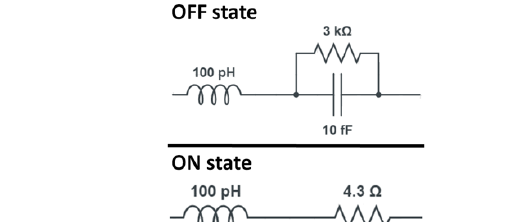
Figure 4. RLC circuit model of an RMSW201 Radant micro-electrical-mechanical system (MEMS) switch.